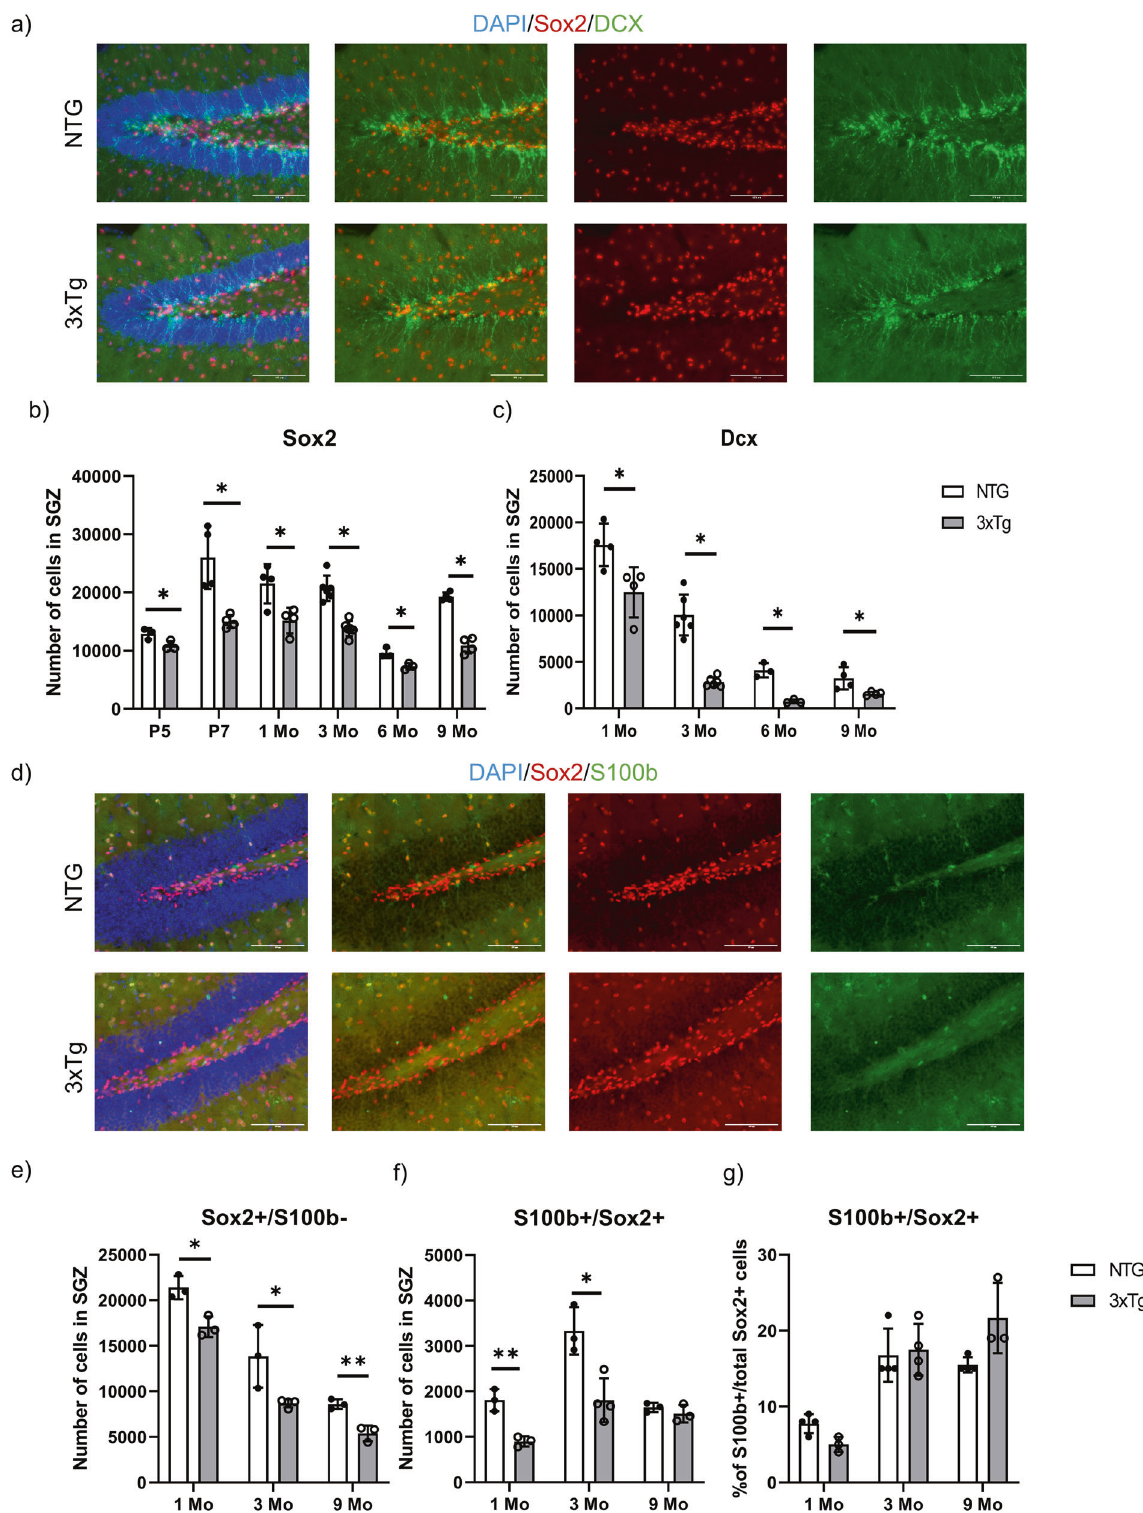
(Figs. 2f, g). To further con fi rm these fi ndings, we double-labeled cells with Sox2 and Hopx, which labels the quiescent Radial Glia- like cells (Type 1, RGL) previously identi fi ed to specify the adult SGZ neurogenic NSCs [33]. Interestingly, Hopx/Sox2-double- labelled NSCs were signi fi cantly reduced in 3xTg mice as early as P5 ((32.9 ± 6.5 % reduction), and P7 (26.6 ± 8.8% reduction),